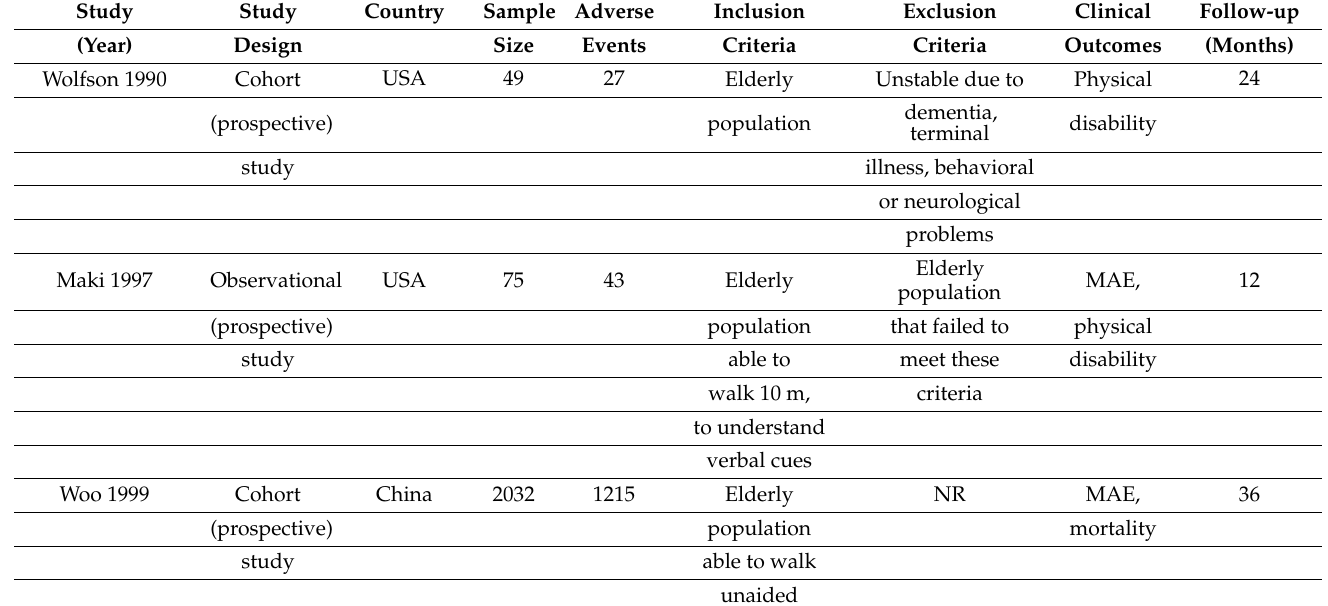
Table 1. Main characteristics of studies included in the